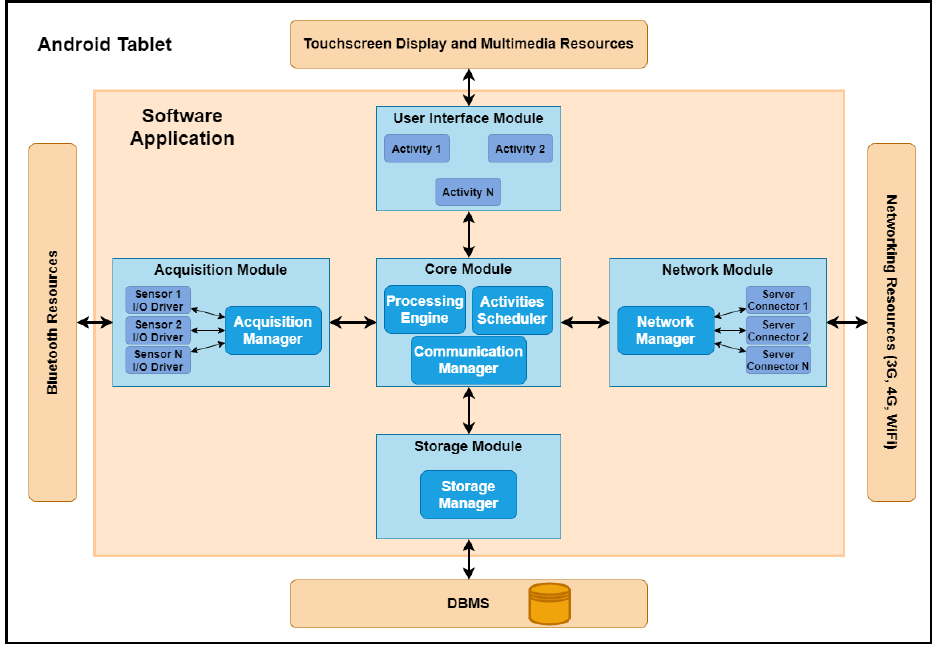
Figure 4. Architecture of the E@syCare smart-hub module [24].